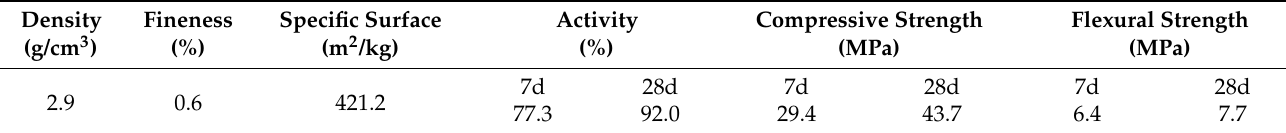
Table 3. Physical properties of the blast furnace slag powder.